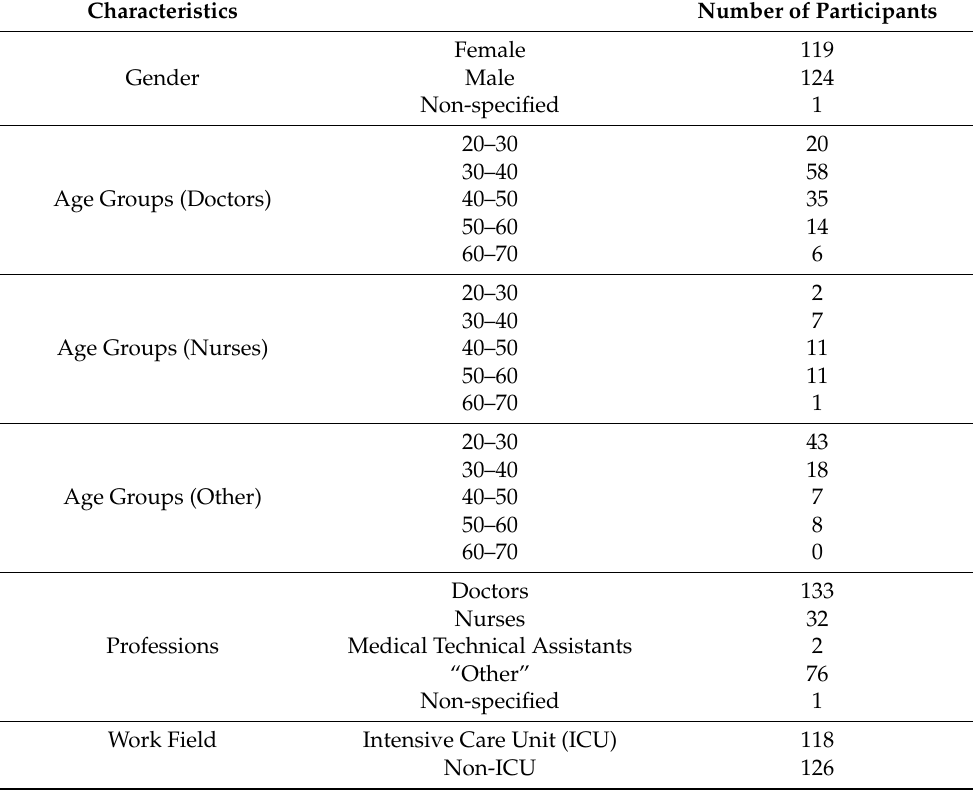
Table 1. Characteristics of the participants.